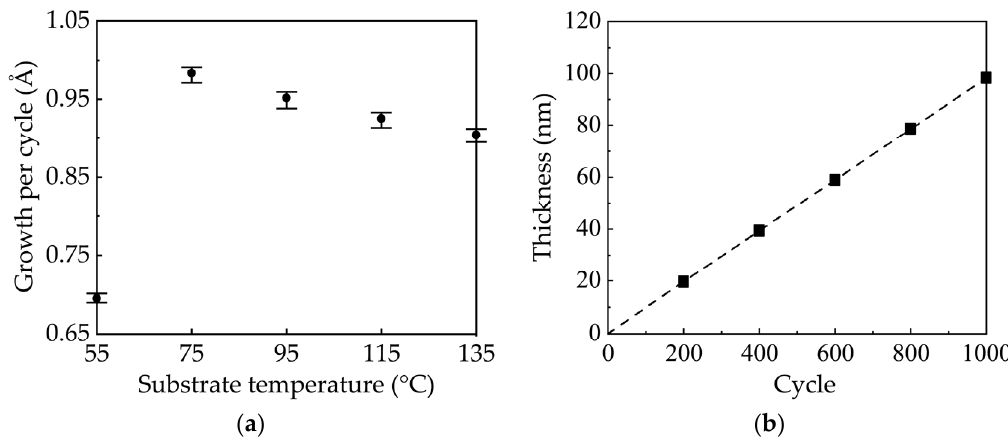
Figure 2. ( a ) Variation in the growth per cycle (GPC) of sALD-ZnO films as a function of substrate temperatures. ( b ) The film thickness as a function of the number of sALD cycles at a substrate temperature of 75 °C.